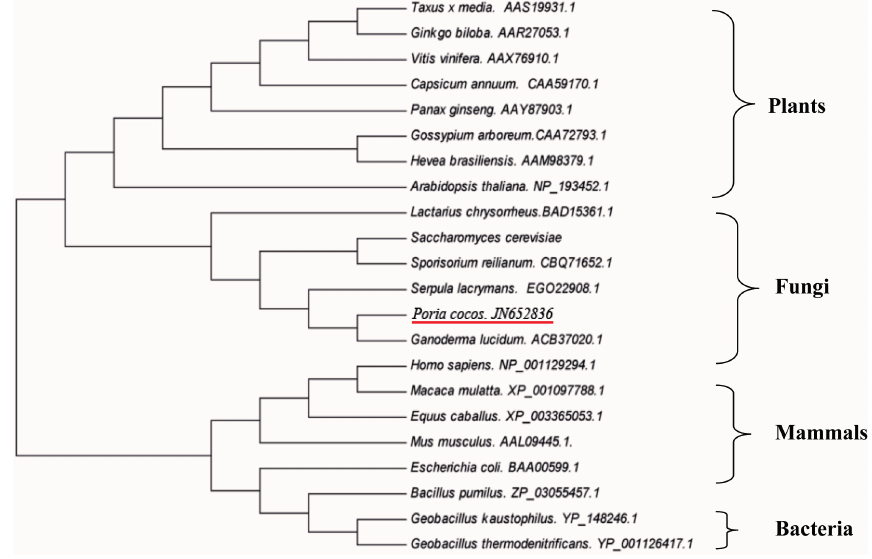
Figure 4. Phylogenetic analysis of FPS amino acid sequences using a neighbor-joining (NJ) method. Twenty-two sequences from different species were retrieved from